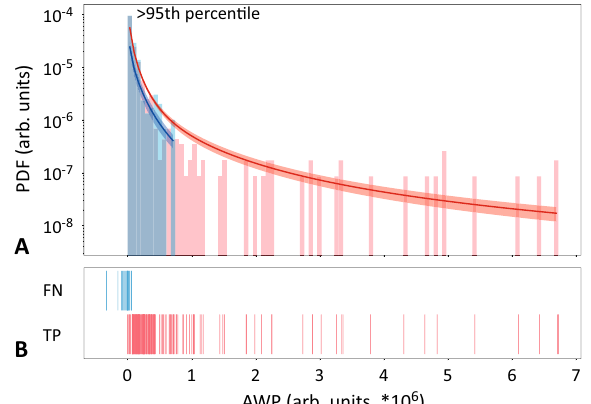
norm 100% TPR (shown as red histogram) and 0% TPR (blue histogram) and group Figure 5. ( A ) PDF of e m for Weibull approximation (mean ± SE) for 100% TPR dataset (red) and 0% TPR dataset (blue); ( B ) marking for TPs (red) and FNs